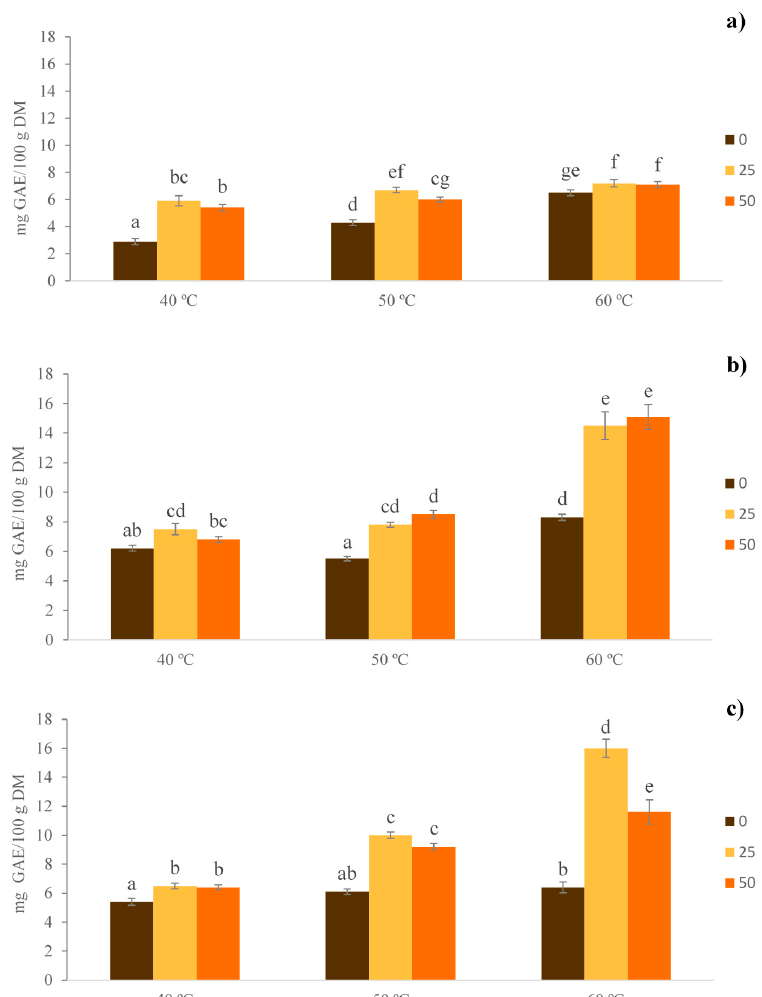
Figure 1. Content of total phenolic compounds, after extraction with different hydroethanolic mixtures (0%, 25% and 50% ethanol:water, v / v ); temperature (40, 50 and 60 °C); and extraction time. ( a ) 1 h; ( b ) 2 h; and ( c ) 3 h. Different letters show statistically significant differences ( p < 0.05) for temperatures and concentrations of ethanol used. DM: dry matter.